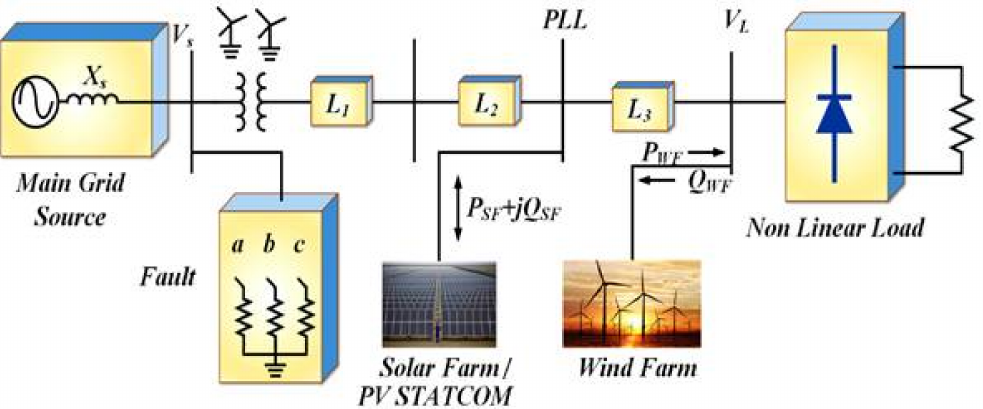
Figure 3. Proposed test model of the Grid Integrated Wind-PV System for the mitigation of harmonics and voltage